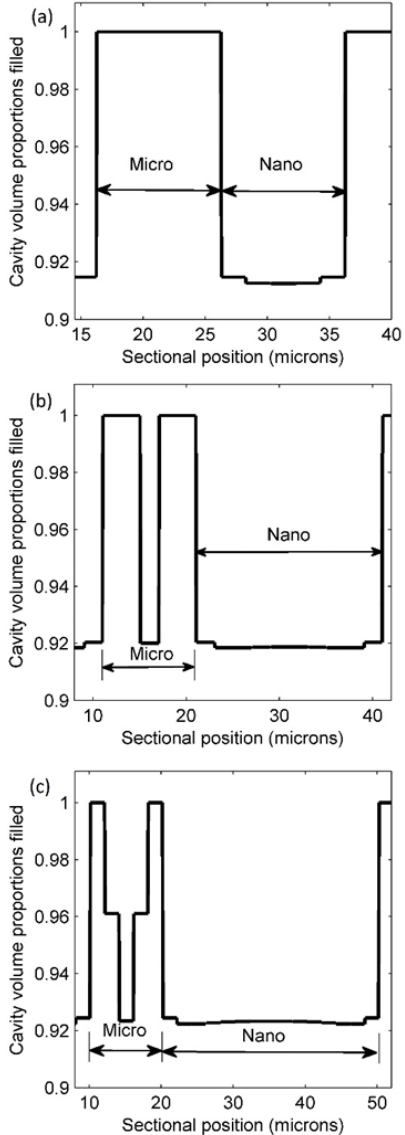
Figure 7. Filled cavity profiles at micro/nano ratios of ( a ) 1:1; ( b ) 1:2; and ( c ) 1:3.